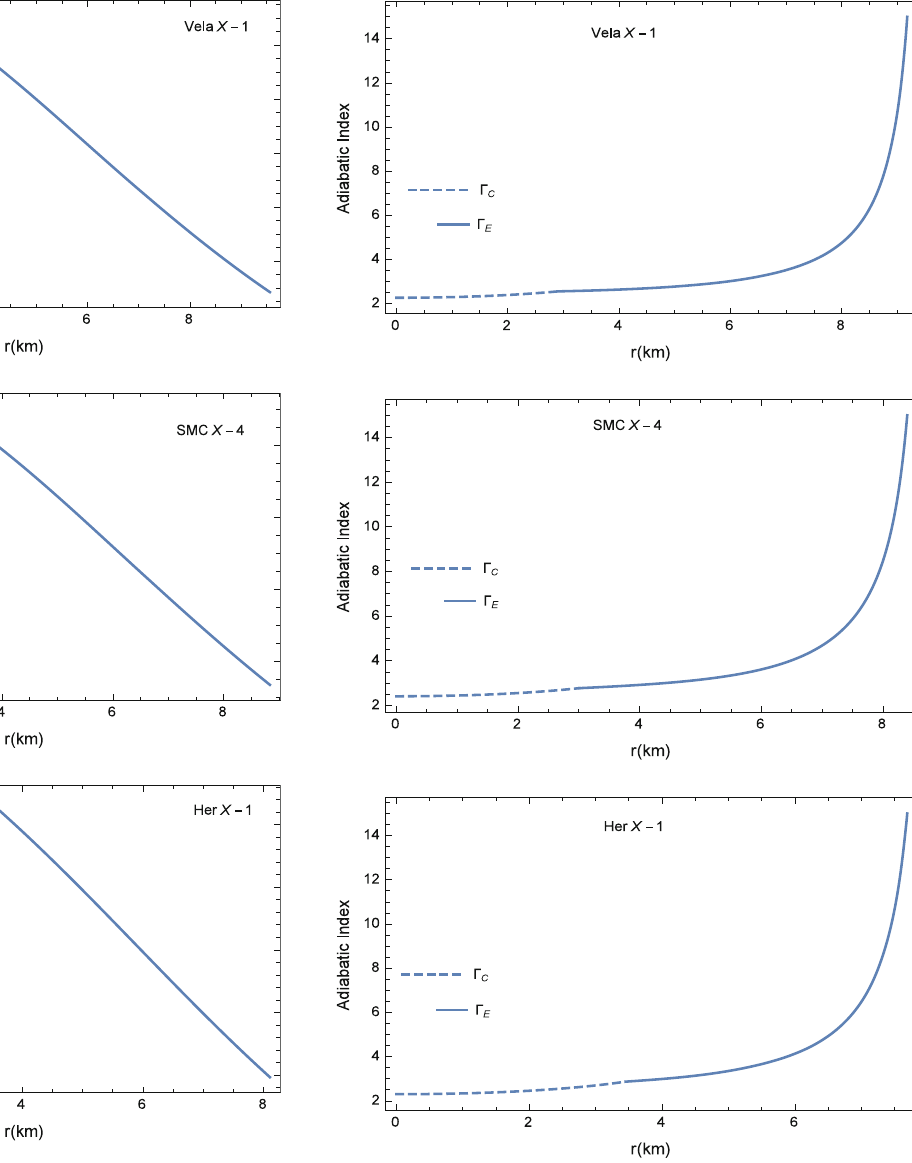
Fig. 10 Variation of adiabatic index with radial coordinate r for (i) the neutron star in Vela X-1(upper) (ii) SMC X-4 (middle) (iii) Her X-1 (lower)